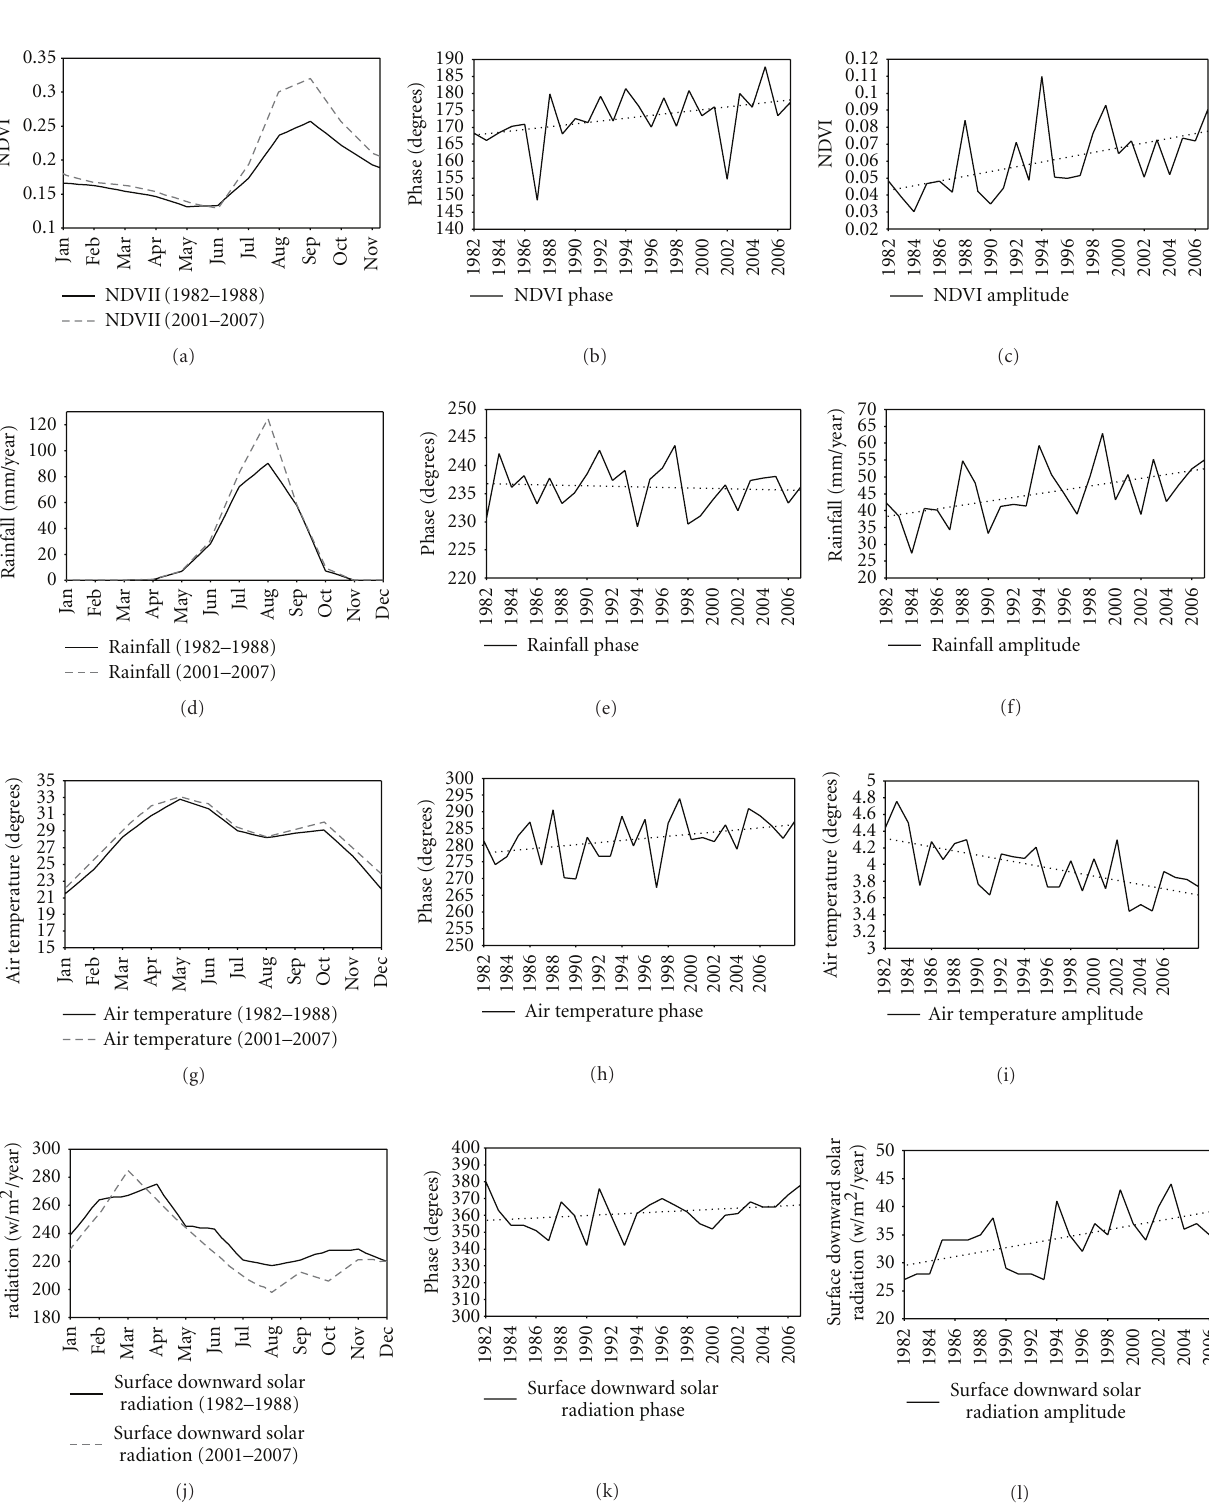
Figure 5: (a) Observed seasonal NDVI curves, Sahel 1982–2007 (black line: first 7 years, dashed black line: last 7 years). (b) NDVI amplitude 1 index series, Sahel 1982–2007. (c) NDVI phase 1 index series, Sahel 1982–2007. (d) Observed seasonal rainfall curves. (e) Rainfall amplitude 1 index series. (f) Rainfall phase 1 index series. (g) Observed seasonal air temperature curves. (h) Air temperature amplitude 1 index series. (i) Air temperature phase 1 index series. (j) Observed seasonal surface downward solar radiation flux. (k) Surface downward solar radiation flux amplitude 1 index series. (l) Surface downward solar radiation flux phase 1 index